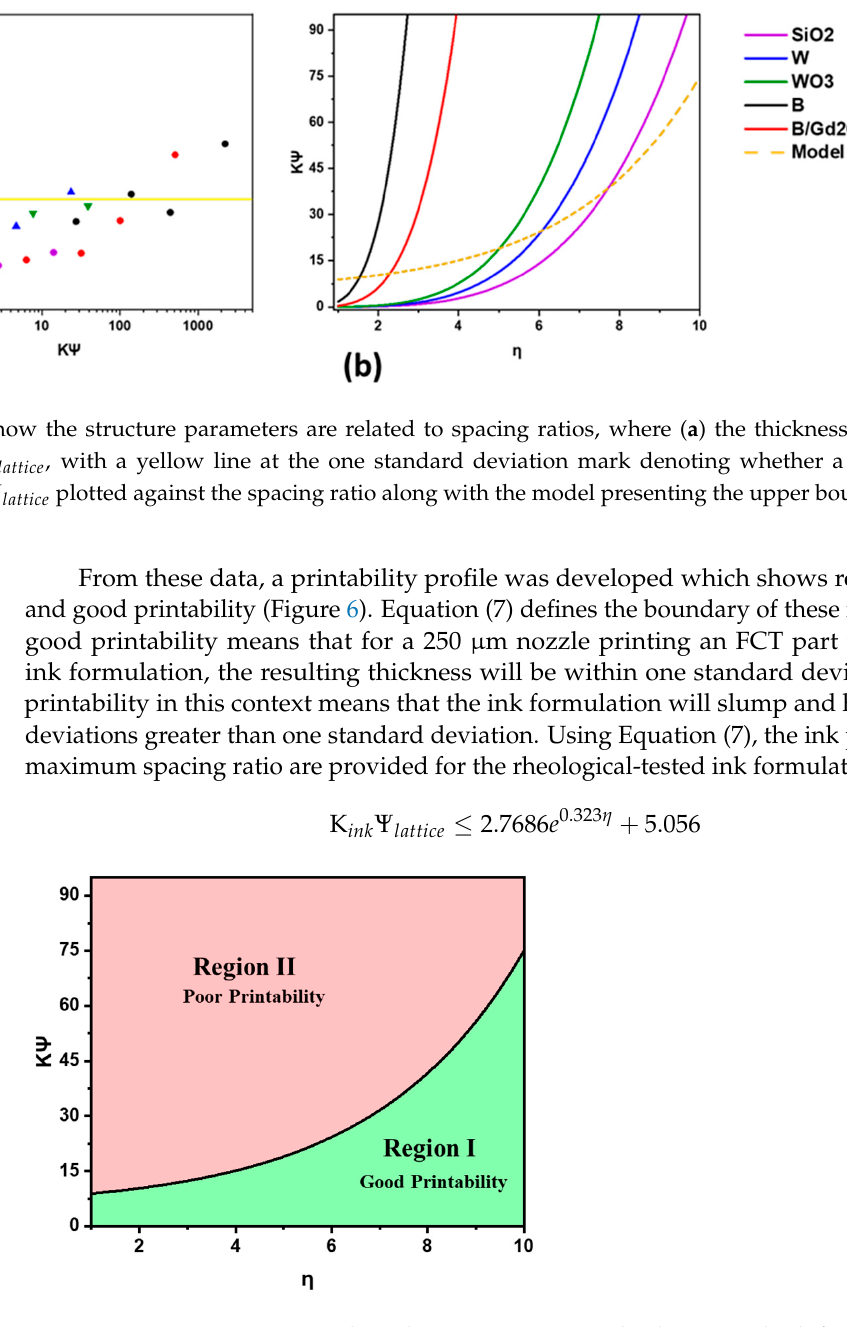
Figure 6. Using a 250 µ m nozzle and an FCT geometry, rheology-tested ink formulations were as-